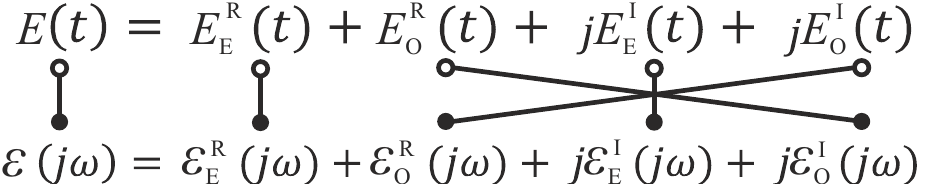
Figure 2. Dependencies of complex-valued time signal and the corresponding spectrum sub-divided into even (E) and odd (O) valued functions. The handle bar shows the